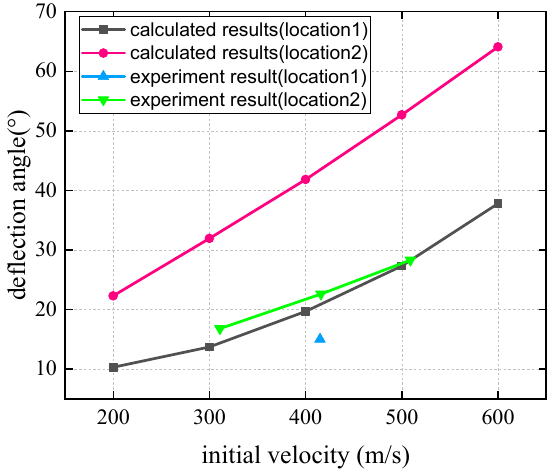
Figure 15. The relationship between the deflection angle and impact velocity of projectile.